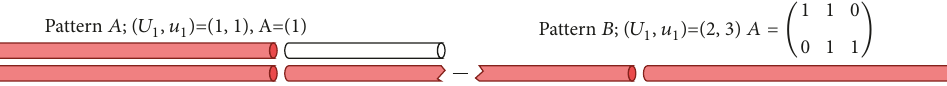
size 𝑠 2 , . . . , the (𝑢 1 + 𝑢 2 ) th column the 𝑢 2 th pipe of size 𝑠 2 , and so on. If rows are indexed by 𝑟 , columns by 𝑐 , and